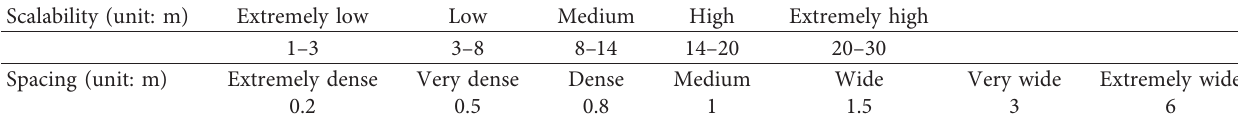
Table 1: Representative values of joint spacing and persistence.